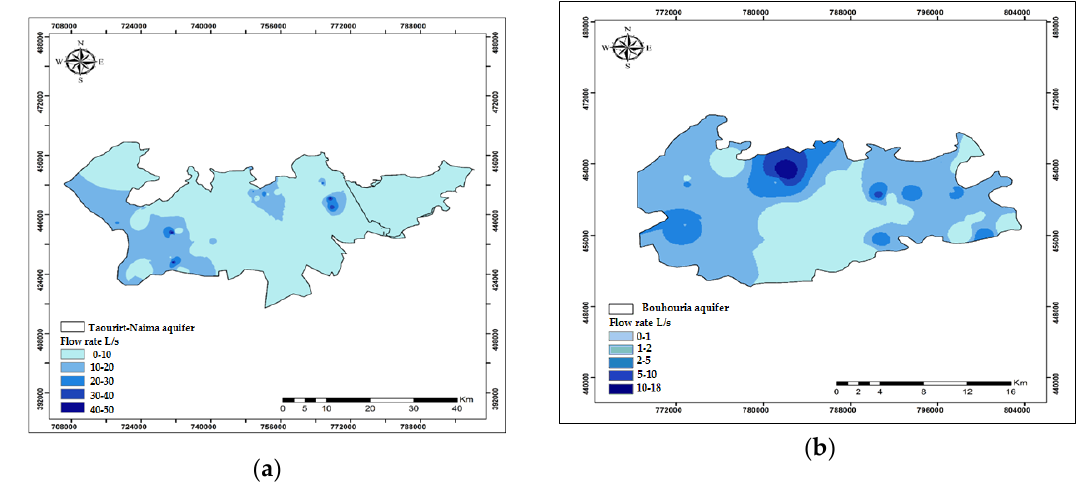
Figure 7. Productivity of T.O.C. aquifers: ( a ) Taourirt-Naima aquifer, ( b ) Bouhouria aquifer.